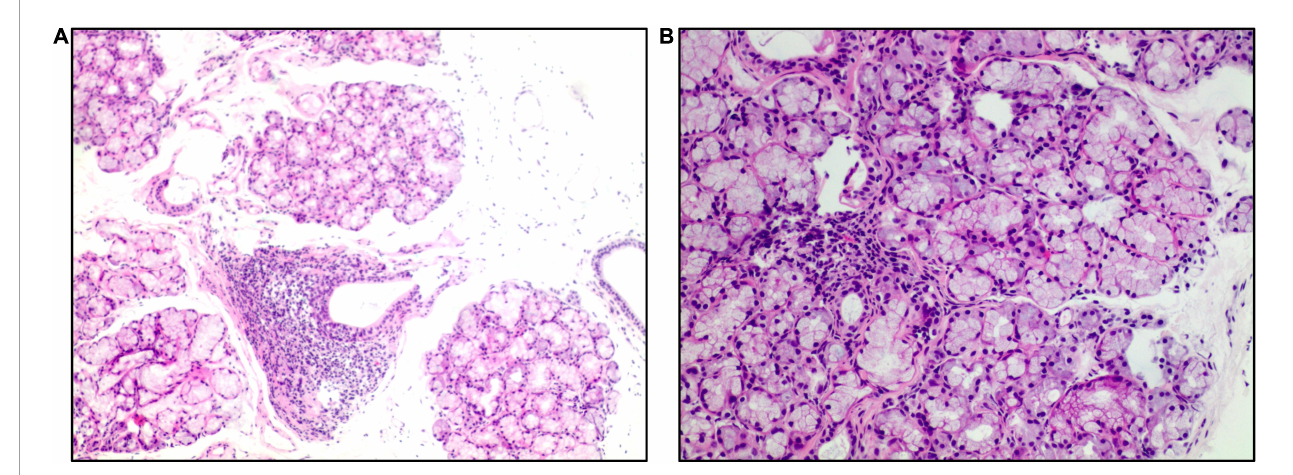
FIGURE2 Salivary gland biopsy (hematoxylin and eosin). Panel (A) ( × 40 magnification) shows multiple labial glandular lobules, local atrophy of individual acini and interstitial fibrosis. Panel (B) ( × 100 magnification) shows a lymphocytic